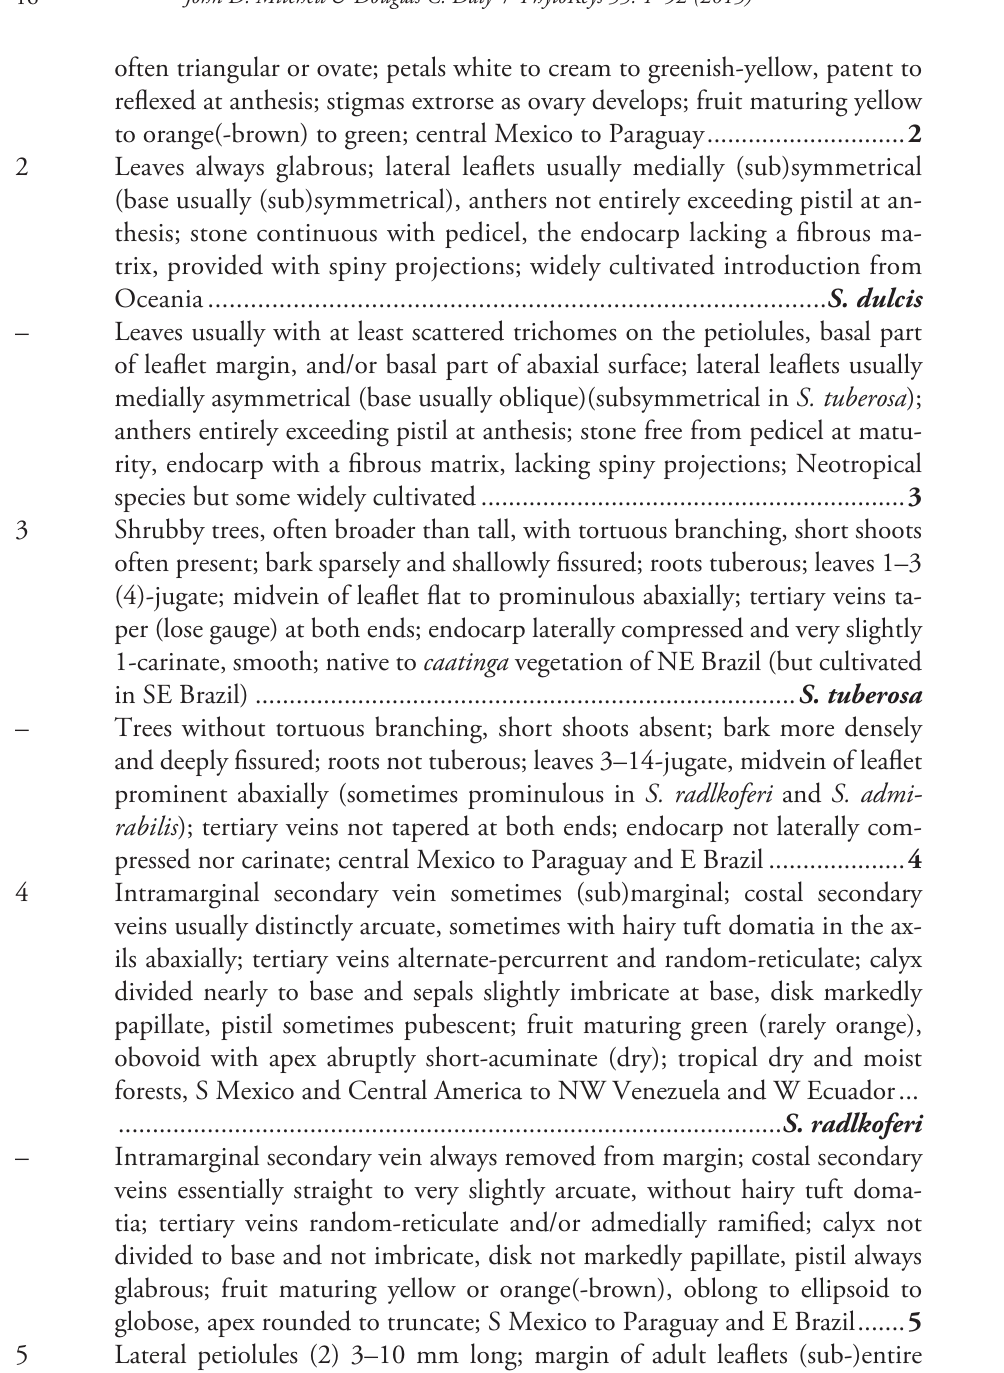
often triangular or ovate; petals white to cream to greenish-yellow, patent to reflexed at anthesis; stigmas extrorse as ovary develops; fruit maturing yellow to orange(-brown) to green; central Mexico to Paraguay ............................. 2 Leaves always glabrous; lateral leaflets usually medially (sub)symmetrical (base usually (sub)symmetrical), anthers not entirely exceeding pistil at an- thesis; stone continuous with pedicel, the endocarp lacking a fibrous ma- trix, provided with spiny projections; widely cultivated introduction from – Leaves usually with at least scattered trichomes on the petiolules, basal part of leaflet margin, and/or basal part of abaxial surface; lateral leaflets usually medially asymmetrical (base usually oblique)(subsymmetrical in S. tuberosa ); anthers entirely exceeding pistil at anthesis; stone free from pedicel at matu- rity, endocarp with a fibrous matrix, lacking spiny projections; Neotropical species but some widely cultivated .............................................................. 3 3 Shrubby trees, often broader than tall, with tortuous branching, short shoots often present; bark sparsely and shallowly fissured; roots tuberous; leaves 1–3 (4)-jugate; midvein of leaflet flat to prominulous abaxially; tertiary veins ta- per (lose gauge) at both ends; endocarp laterally compressed and very slightly 1-carinate, smooth; native to caatinga vegetation of NE Brazil (but cultivated in SE Brazil) ............................................................................... S. tuberosa – Trees without tortuous branching, short shoots absent; bark more densely and deeply fissured; roots not tuberous; leaves 3–14-jugate, midvein of leaflet prominent abaxially (sometimes prominulous in S. radlkoferi and S. admi- rabilis ); tertiary veins not tapered at both ends; endocarp not laterally com- pressed nor carinate; central Mexico to Paraguay and E Brazil .................... 4 4 Intramarginal secondary vein sometimes (sub)marginal; costal secondary veins usually distinctly arcuate, sometimes with hairy tuft domatia in the ax- ils abaxially; tertiary veins alternate-percurrent and random-reticulate; calyx divided nearly to base and sepals slightly imbricate at base, disk markedly papillate, pistil sometimes pubescent; fruit maturing green (rarely orange), obovoid with apex abruptly short-acuminate (dry); tropical dry and moist forests, S Mexico and Central America to NW Venezuela and W Ecuador ... – Intramarginal secondary vein always removed from margin; costal secondary veins essentially straight to very slightly arcuate, without hairy tuft doma- tia; tertiary veins random-reticulate and/or admedially ramified; calyx not divided to base and not imbricate, disk not markedly papillate, pistil always glabrous; fruit maturing yellow or orange(-brown), oblong to ellipsoid to globose, apex rounded to truncate; S Mexico to Paraguay and E Brazil ....... 5 5 Lateral petiolules (2) 3–10 mm long; margin of adult leaflets (sub-)entire (very rarely crenulate or serrulate) and usually flat; trichomes on leaflets all straight and short (not exceeding 0.3 mm), glandular trichomes absent ......